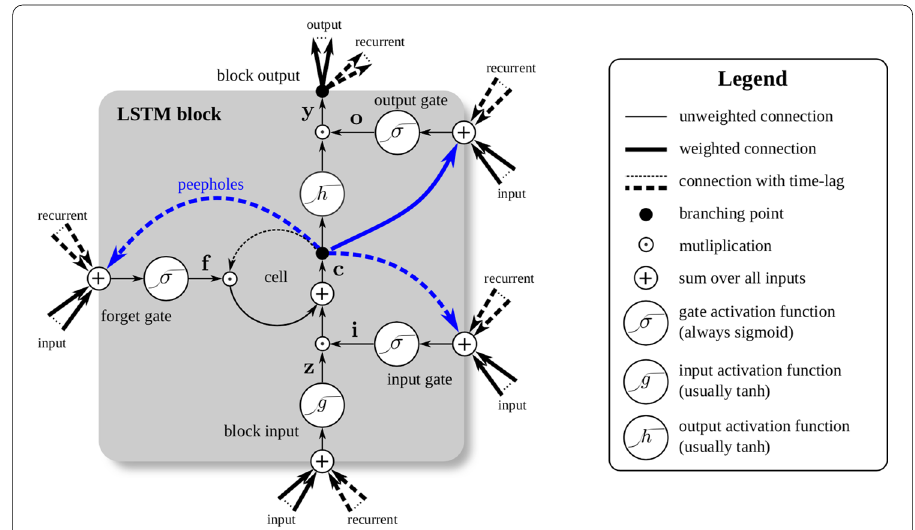
Fig. 1 Vanilla LSTM (Greff et al.